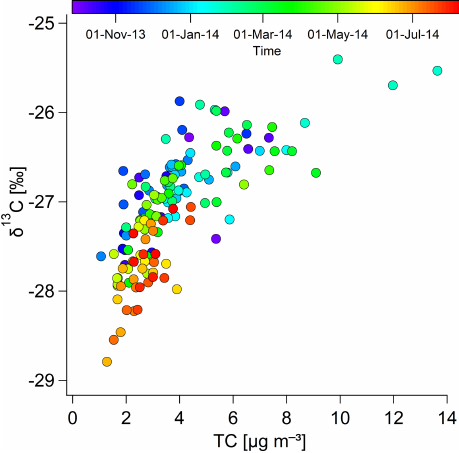
concentrations. 3 Figure 6. Relationship between TC and δ 13 C. The color scale re- concentrations. The color 4 flects the time of sample